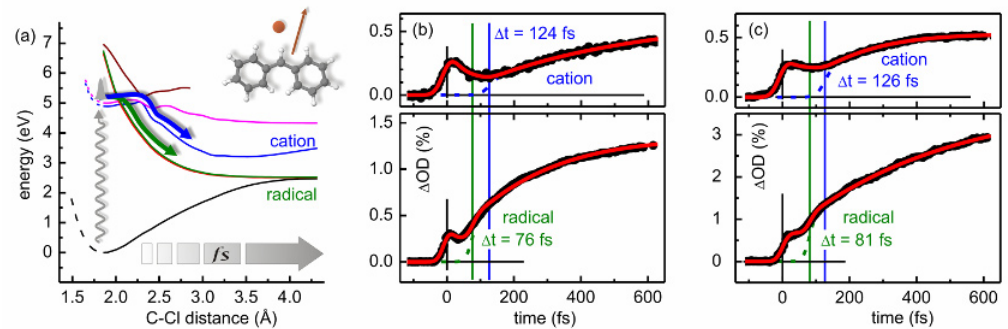
Fig. 1. (a) Potential energy surface of diphenylmethylchloride. After ballistic motion out of the Franck- Condon region, the excited wave-packet splits, leading to the ultrafast generation of radical and ion pairs. (b) Transient absorption of the photoproducts. Due to the nearer interaction region, the radical appears ~50 fs earlier than the cation. (c) A similar dynamics is observed in the 3-fluoro